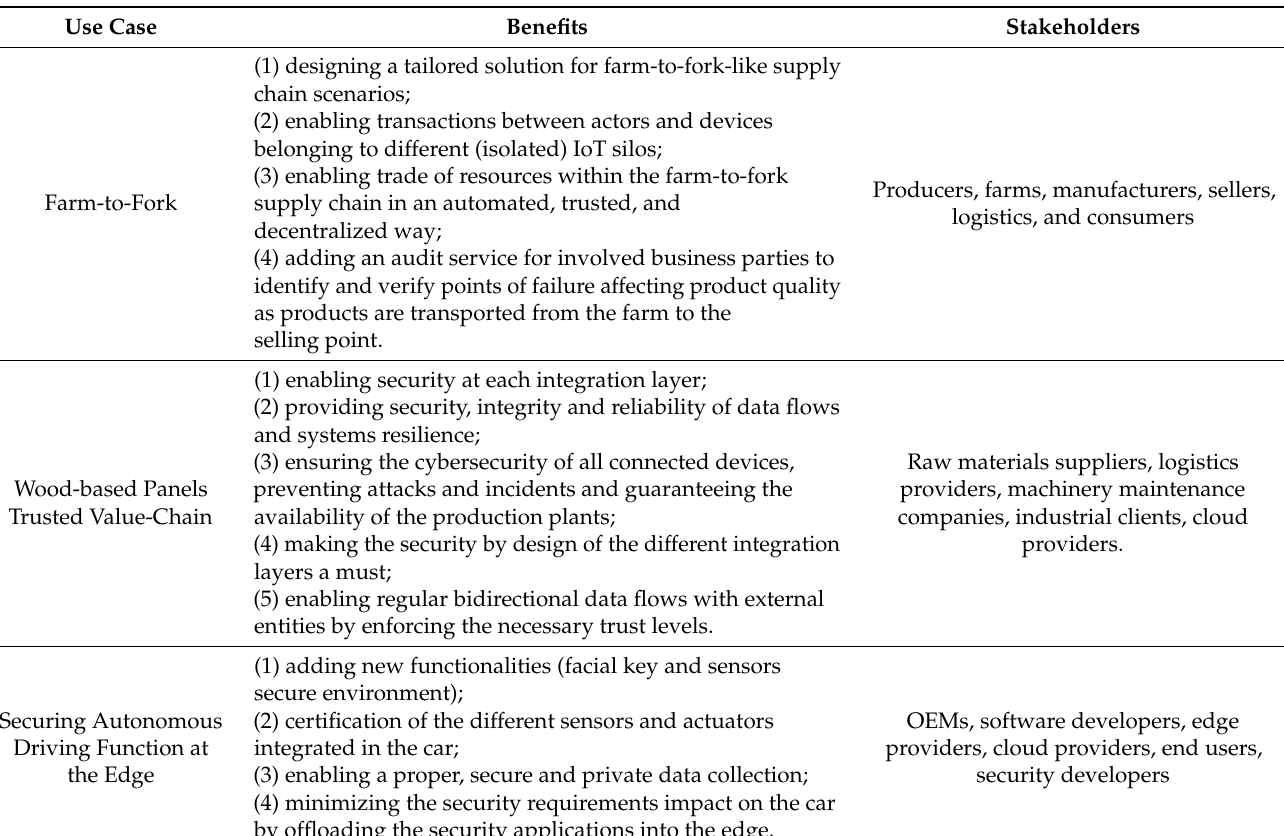
Table 2. Use cases benefits and key